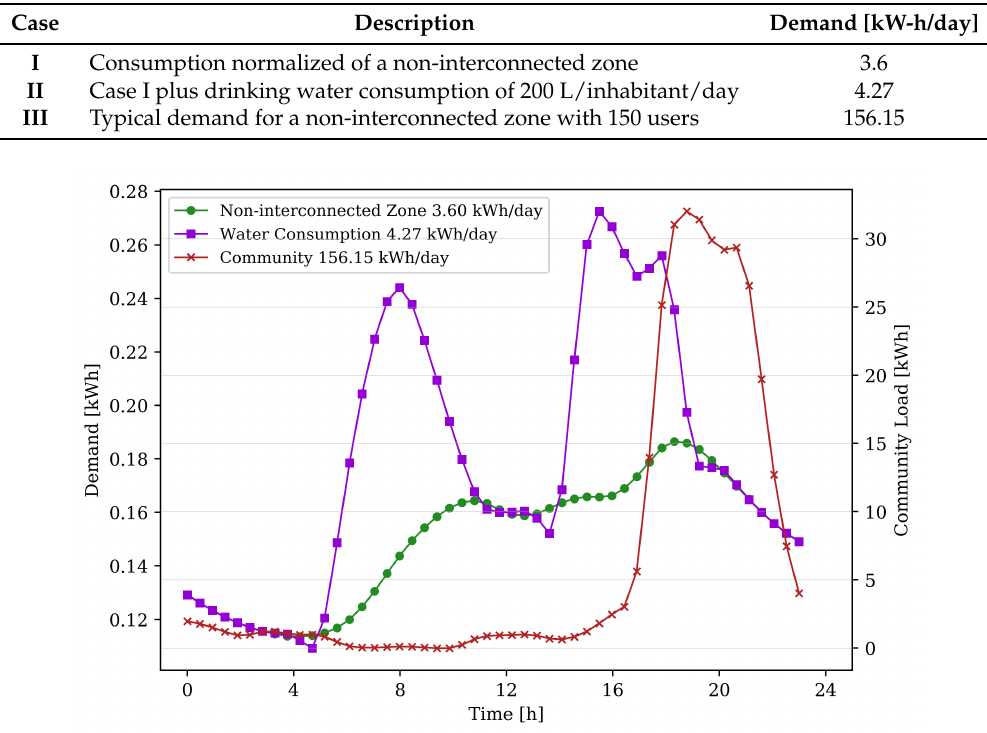
Figure 2. Demand